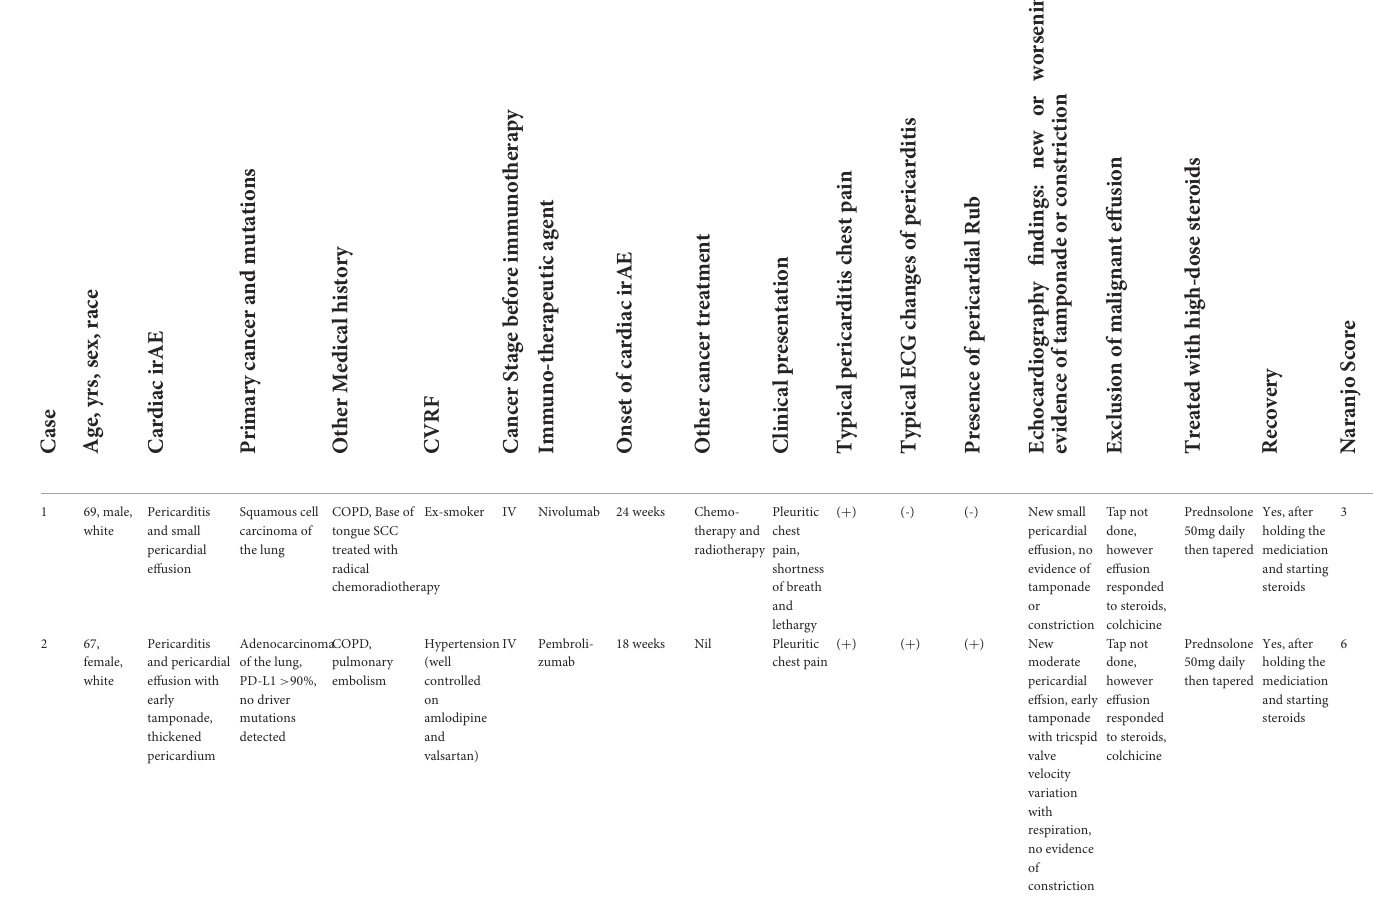
6 ( + )9weeks reintroductionNil afterfirst reintroduction and27 weeksafter second